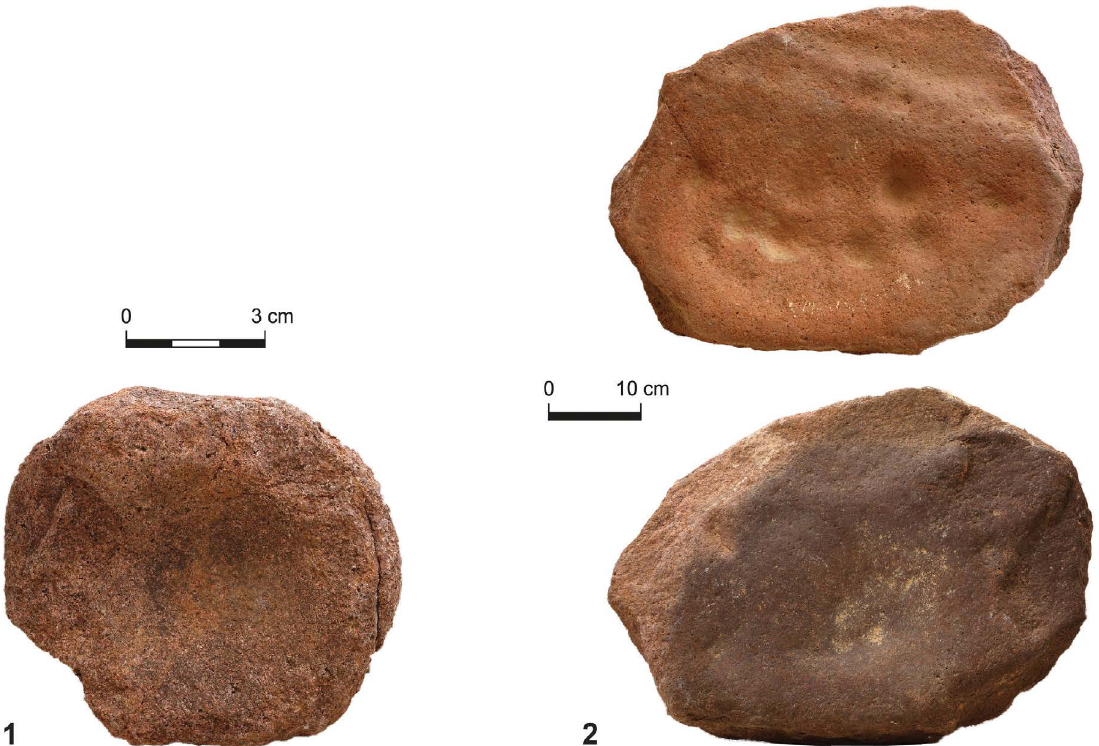
Figure 11. (1) B.35 (survey): granite mortar; (2) B.18 (survey): large granite anvil or mortar with multiple cup marks on both sides, as well as a smoothed surface.